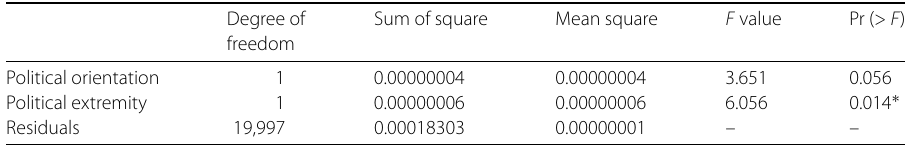
Table 15 Multi-group mean comparisons of harm avoidance using Tukey’s HSD test Mean 95% Confidence interval Adjusted difference P-valueLower Upper bound bound lwe-lw –0.0001 –0.0006 0.0004 0.9453 rw-lw –0.0003 –0.0008 0.0002 0.4058 rwe-lw –0.0005 –0.0011 0 0.0576 rw-lwe –0.0002 –0.0007 0.0003 0.7547 rwe-lwe –0.0004 –0.0009 0.0001 0.1985 rwe-rw –0.0002 –0.0007 0.0003 0.7327